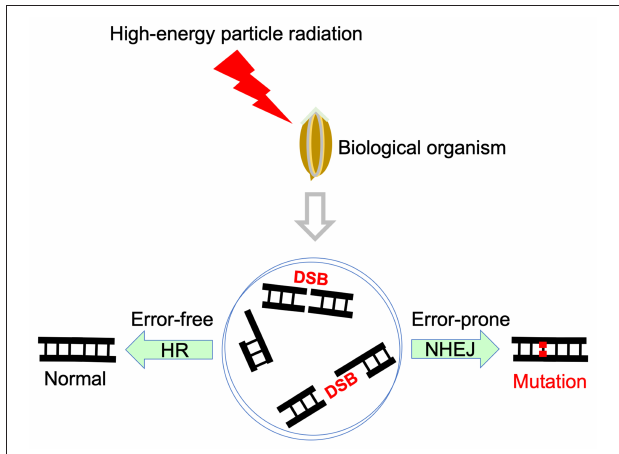
FIGURE 3 | DSB repair pathways induced by high-energy particle